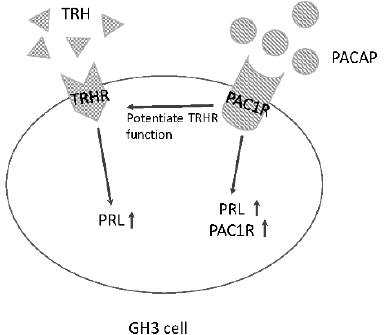
Figure 4. Schematic summary of the action of TRH and PACAP in pituitary prolactin-producing GH3 cells. Both TRH and PACAP increase prolactin gene expression. PACAP also increases the expression of PAC1R. In addition, the presence of PAC1R potentiates the effect of TRH on prolactin gene expression.